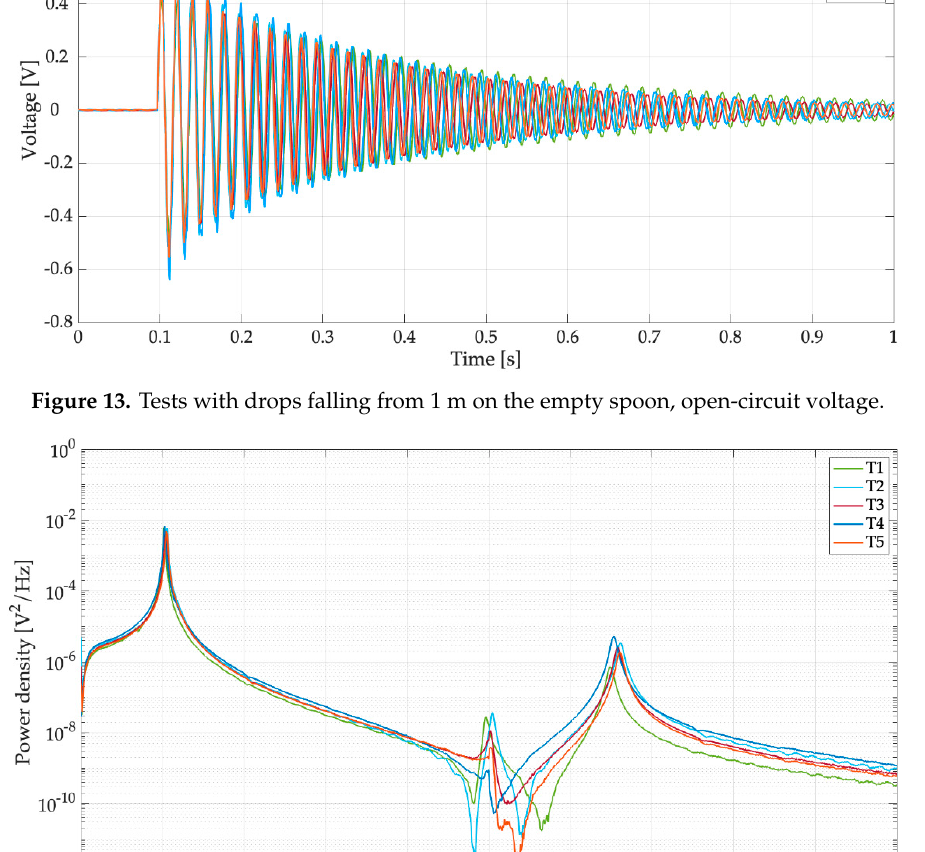
Figure 14. Tests with drops falling from 1 m on the empty spoon, PSDs of open-circuit voltage.